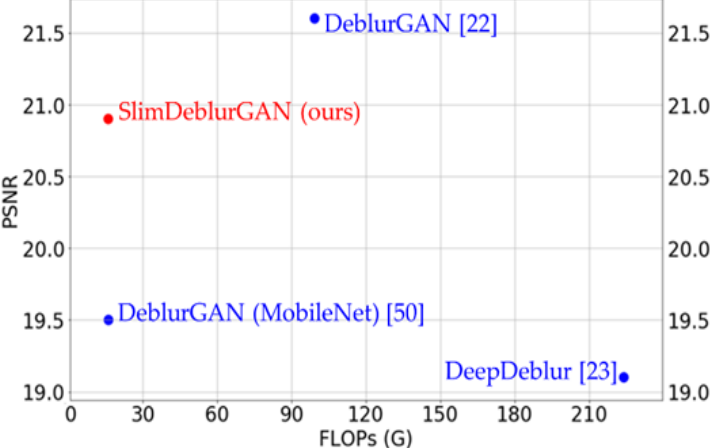
Figure 10. Comparison of DeepDeblur, DeblurGAN, DeblurGAN (MobileNet), and our proposed model of SlimDeblurGAN, in terms of motion deblurring accuracy and the number of FLOPs. Table 8. Comparison of the number of FLOPs and accuracies of Deep Deblur [23], DeblurGAN [22], DeblurGAN using MobileNet [50], and our proposed model, SlimDeblurGAN.